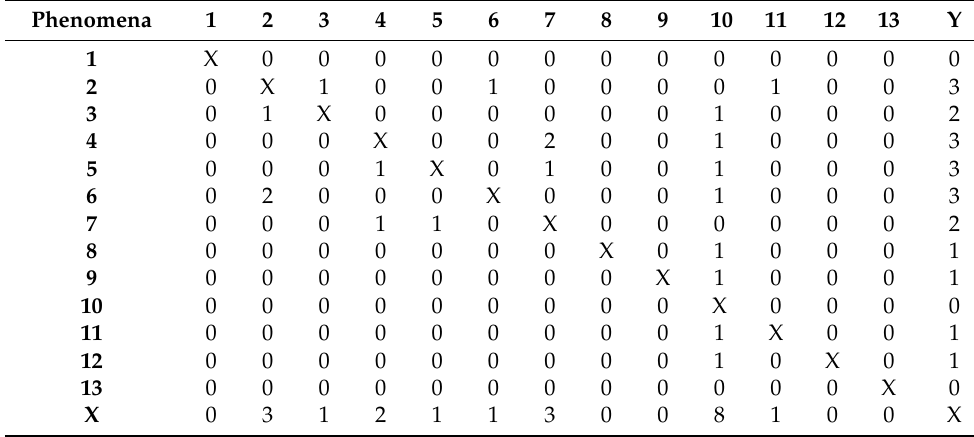
Table 2. Analysis of the relations between the “environment” phenomena.